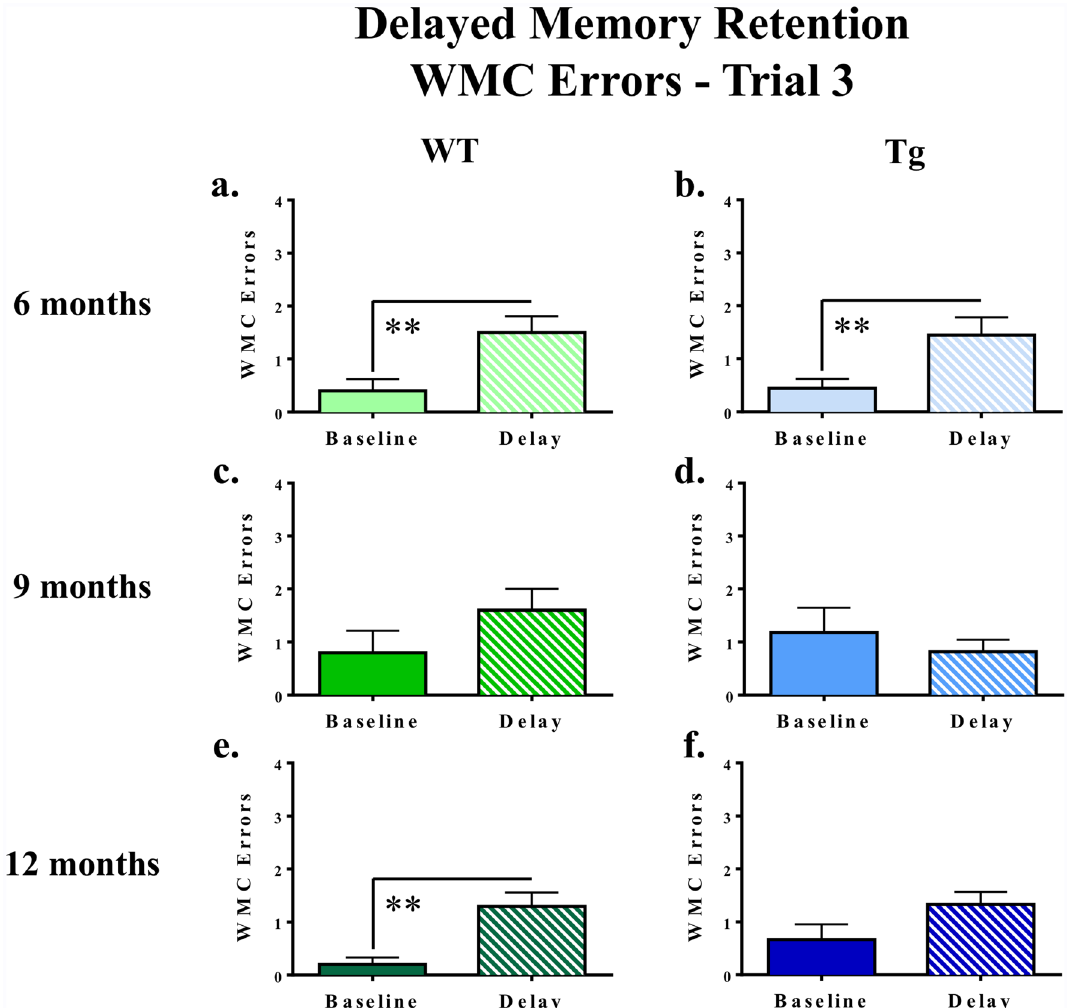
Figure 4. Assessments of delayed memory retention on the WRAM. Following implementation of a 6-h delay on Day 13 of the WRAM, analyses of performance in WMC errors for Trial 3 on Day 12 (Baseline) and Day 13 (Delay) revealed a significant effect of the delay for rats in the 6-month Tg group, the 6-month WT group, and the 12-month WT group. ** p <